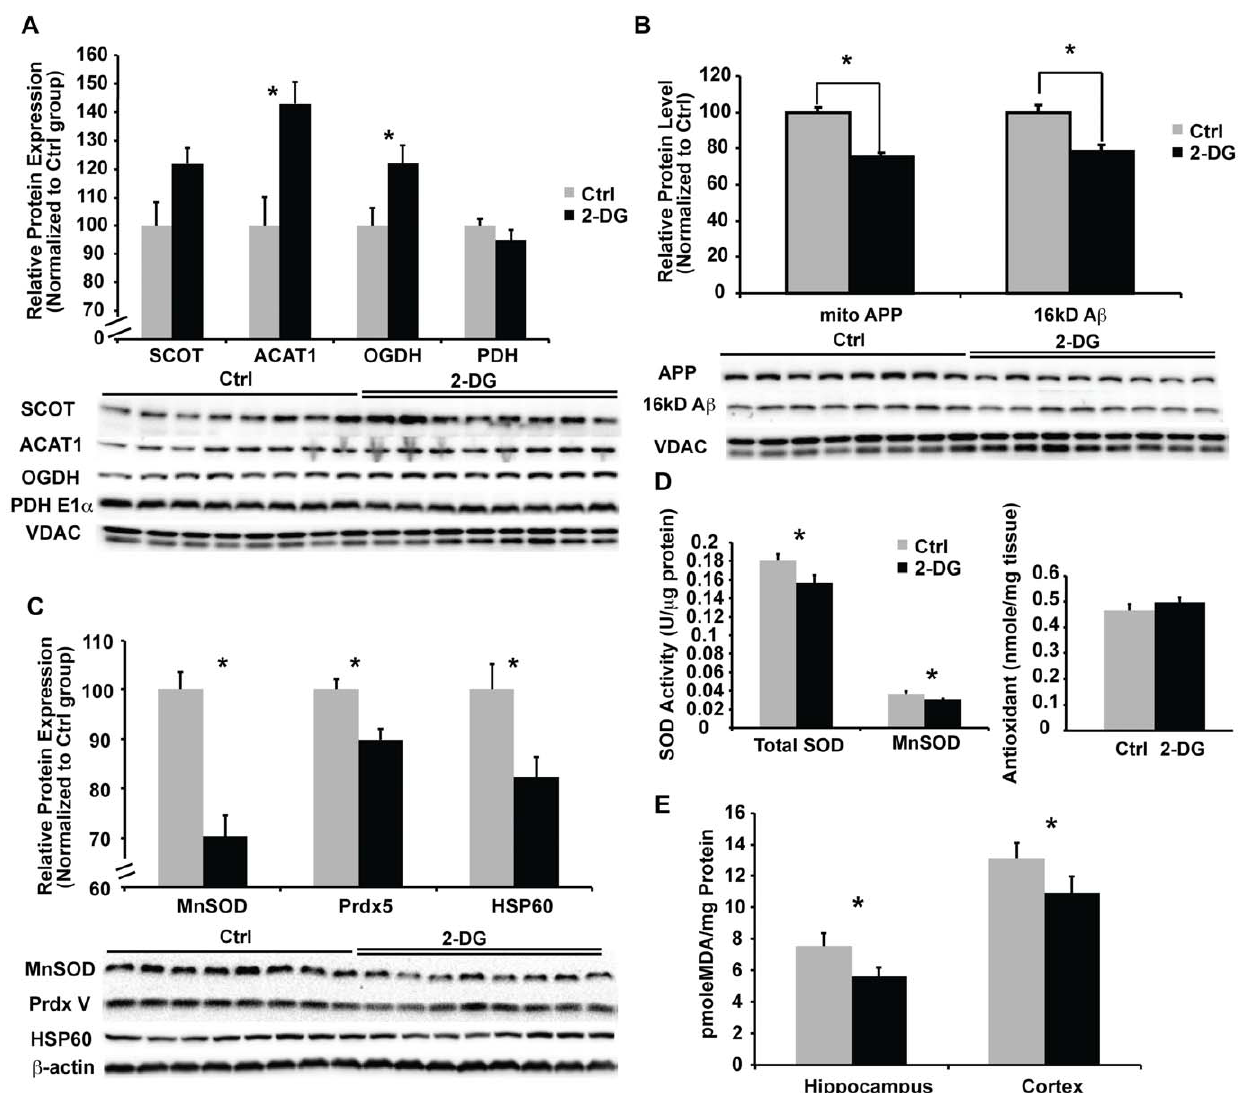
Figure 3. 2-DG sustained mitochondrial bioenergetic function, reduced mitochondrial A b load, and suppressed oxidative stress. Mitochondrial samples of both the Ctrl and 2-DG group were analyzed for protein levels of 1) bioenergetic enzymes, including SCOT, ACAT1, OGDH, and PDH; 2) amyloid species, including APP and 16 kD A b oligomer; 3) oxidative stress markers, including MnSOD, Prdx V, and Hsp60 by western blot. Cortical tissue homogenates from both the Ctrl and 2-DG groups were analyzed for total SOD and MnSOD activity, total anti-oxidant capacity, and lipid peroxidation. A, 2-DG significantly increased protein expression of enzymes involved in ketone utilization, including SCOT, ACAT1 and OGDH; In contrast, PDH was not changed by 2-DG (*, P , 0.05 compared to Ctrl, bars represent mean value 6 SEM); B, 2-DG significantly decreased mitochondrial APP and 16 kD A b oligomer level (*, P , 0.05 compared to Ctrl, bars represent mean value 6 SEM); C, 2-DG significantly decreased protein expression of oxidative stress response markers, including MnSOD, Prdx V, and Hsp60 (*, P , 0.05 compared to Ctrl, bars represent mean value 6 SEM); D, 2-DG significantly decreased both SOD and MnSOD activity while the total anti-oxidant capacity was slightly increased (*, P , 0.05 compared to Ctrl, bars represent mean value 6 SEM); E, 2-DG significantly decreased lipid peroxidation (*, P , 0.05 compared to Ctrl, bars represent mean value 6 SEM).